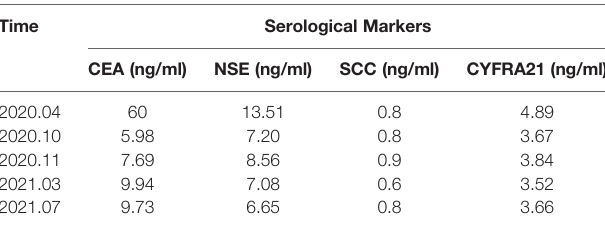
TABLE 1 | The serological examination results at cardiac failure and during recovery treatment. Time Serological